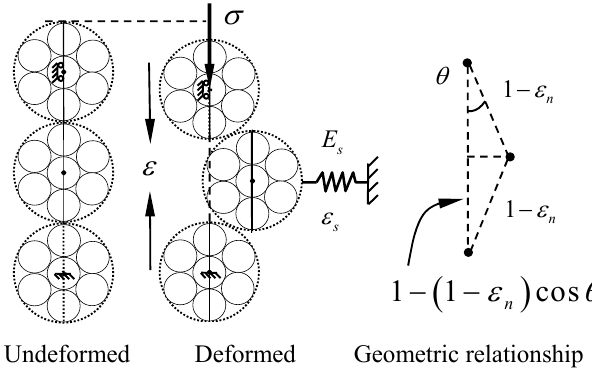
Figure 4. Three-particle force chain model